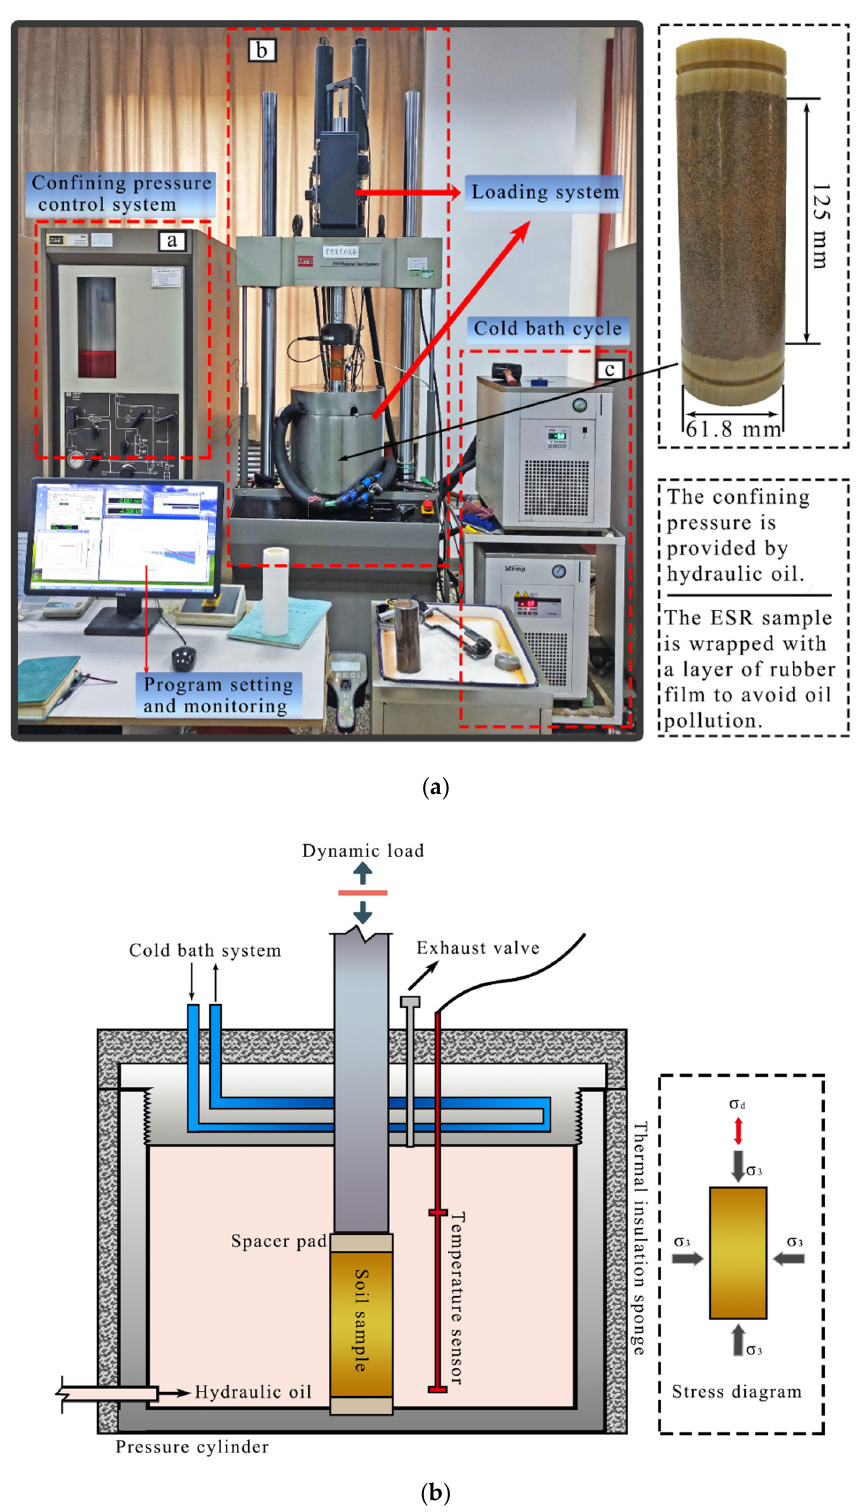
Figure 5. Dynamic triaxial machine (MTS-810(5T)) and specimens. ( a ) The motor triaxial testing machine contains three parts: a. The perioperative pressure control system; b. Loading system; c. Cold bath circulatory system. ( b ) hydraulic oil provides ambient pressure and temperature control is controlled by the cold bath unit and the upper and lower temperature sensors; air should be exhausted by the exhaust valve before testing.